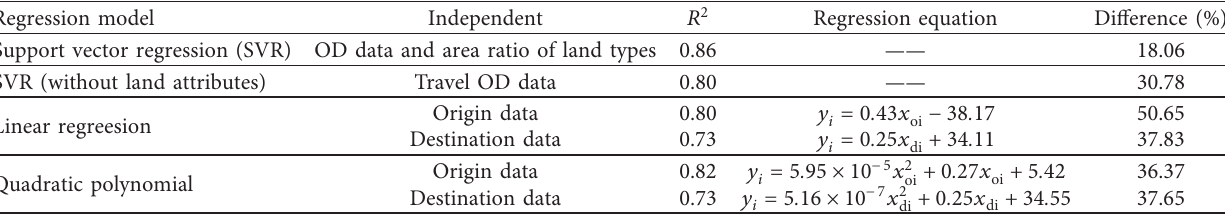
Figure 5: Parking zone division outcomes at different side-length conditions. (a) Statistical information grids with a side length of 300 meters and (b) Statistical information grids with a side length of 100 meters. Table 2: Verification results of different regression models.